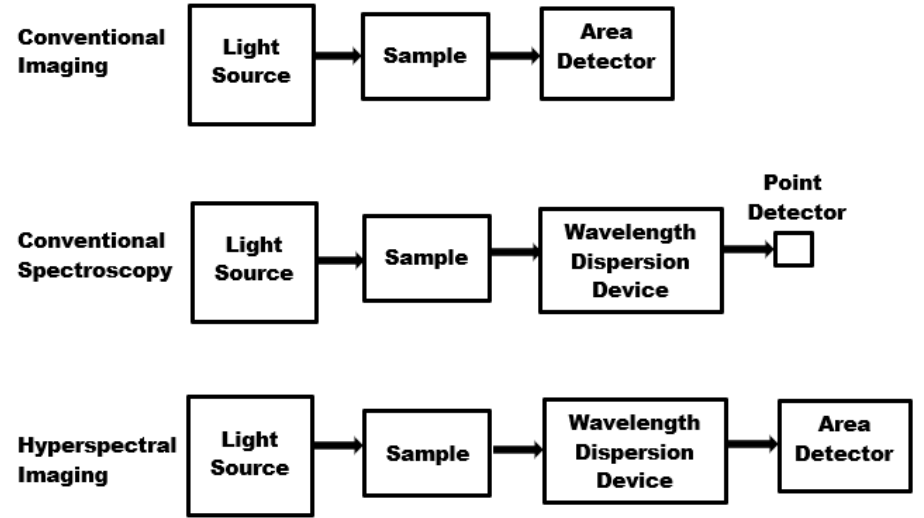
Figure 8. General system configurations for conventional imaging, conventional spectroscopy, and hyperspectral imaging.